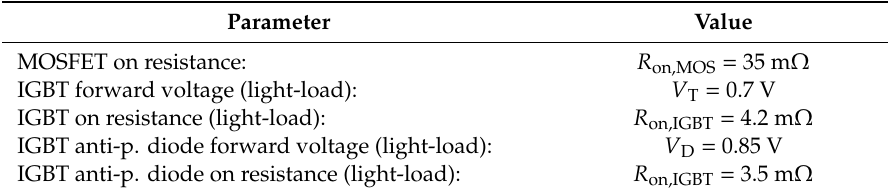
Table 3. Relevant IGBT, dedicated antiparallel diode and SiC MOSFET parameters. Parameter